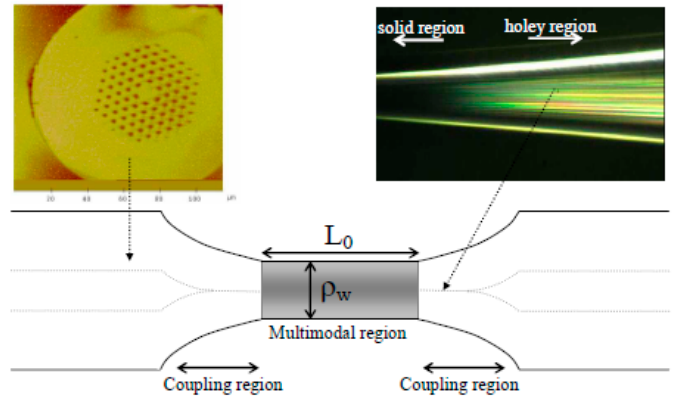
Figure 7. Images of the cross section of an SC-PCF (top left) used to fabricate the tapers and of the expanding zone of the taper (top right). The picture illustrates a tapered SC-PCF. The shadowed area represents the gas-permeable thin film. L 0 is the length of the solid multimodal section and ρ w is the taper waist diameter. Reprinted with permission from [77] © 2006 Optical Society of America.